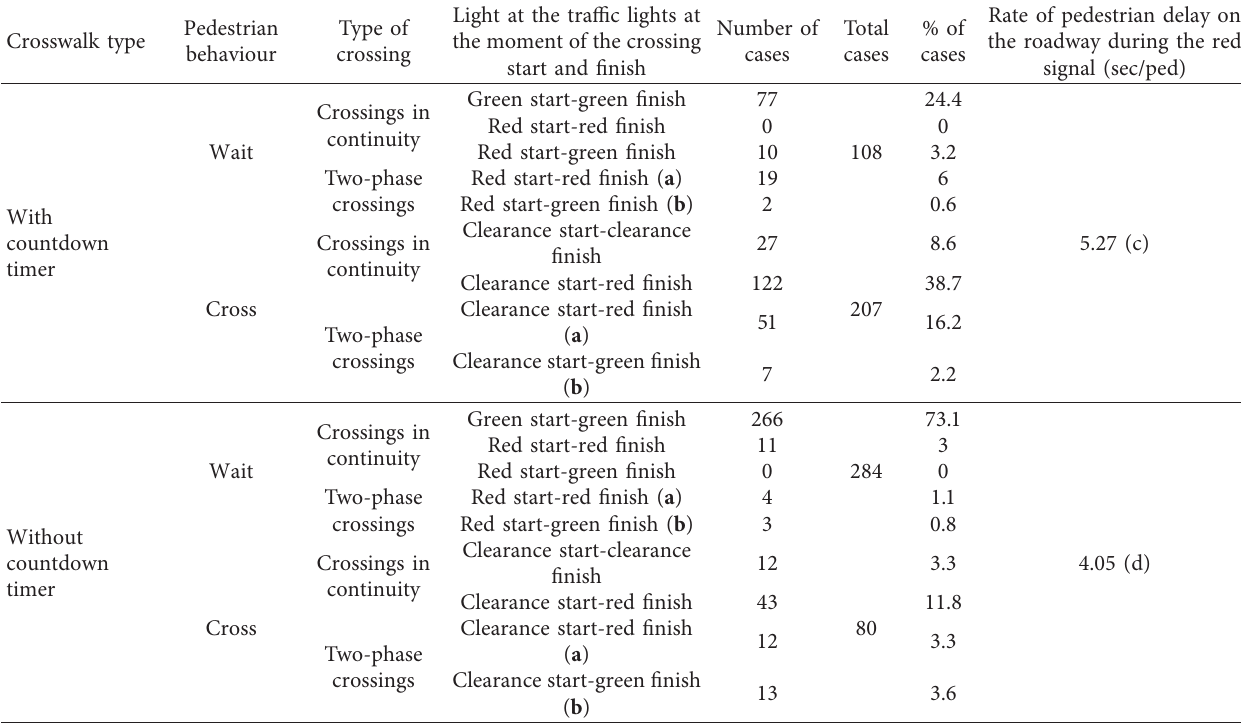
Table 3: Types of pedestrians’ roadway crossings and delay rate. Crosswalk